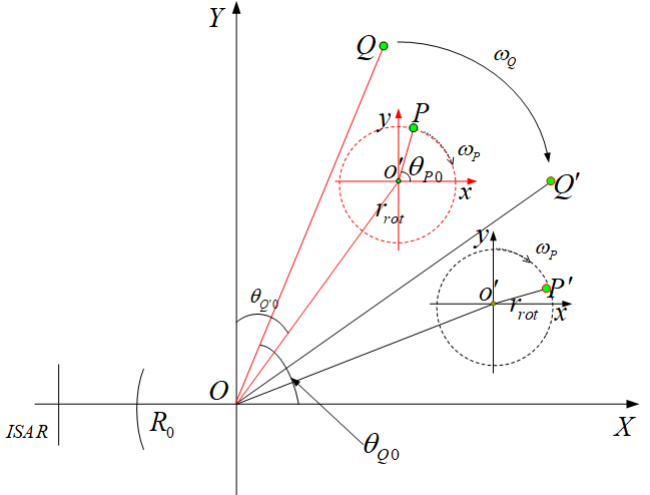
Figure 1. ISAR geometric